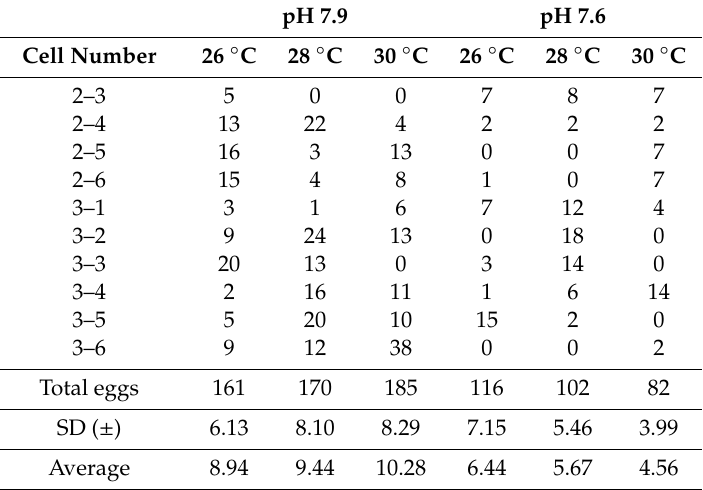
Figure 5. Hatching success of Acartia ohtsukai eggs over time when maintained under two different pH and three different temperature conditions.